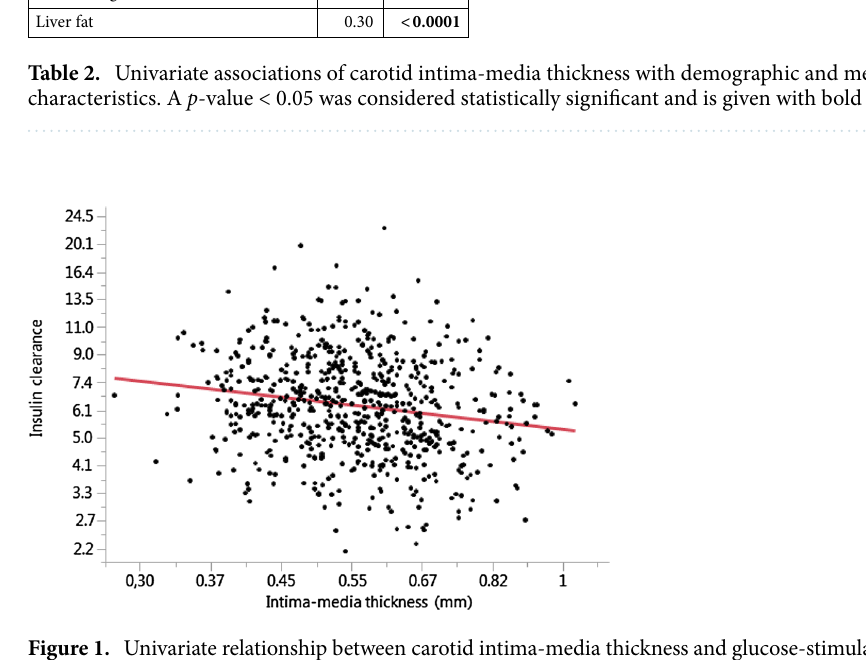
Figure 1. Univariate relationship between carotid intima-media thickness and glucose-stimulated insulin